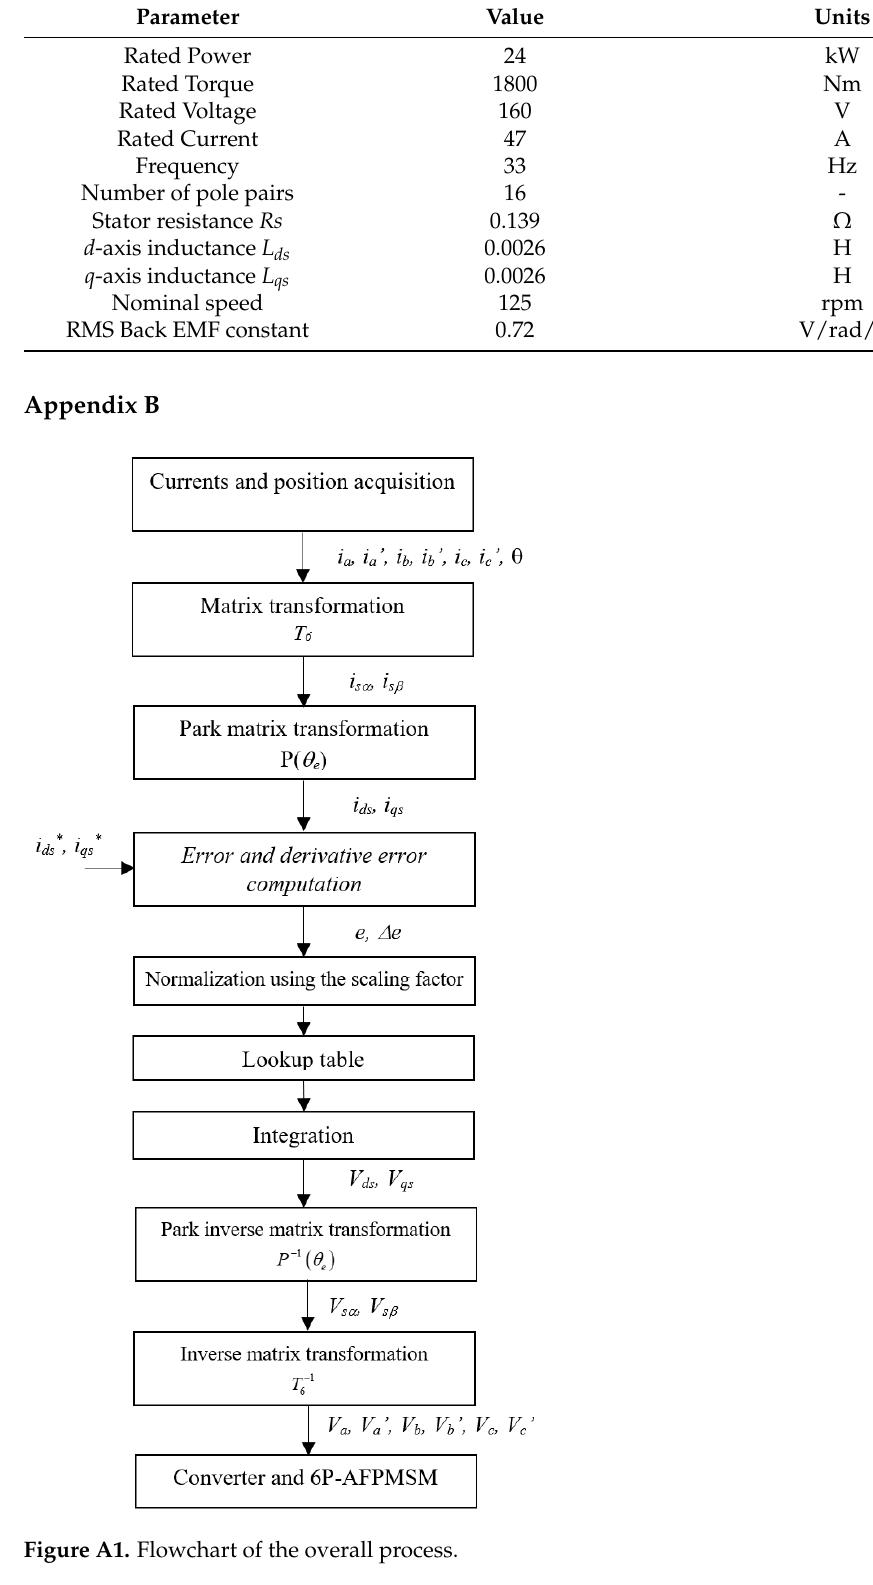
Table A2. PI-Controller Parameters of the 6P-AFPMSM. Parameter